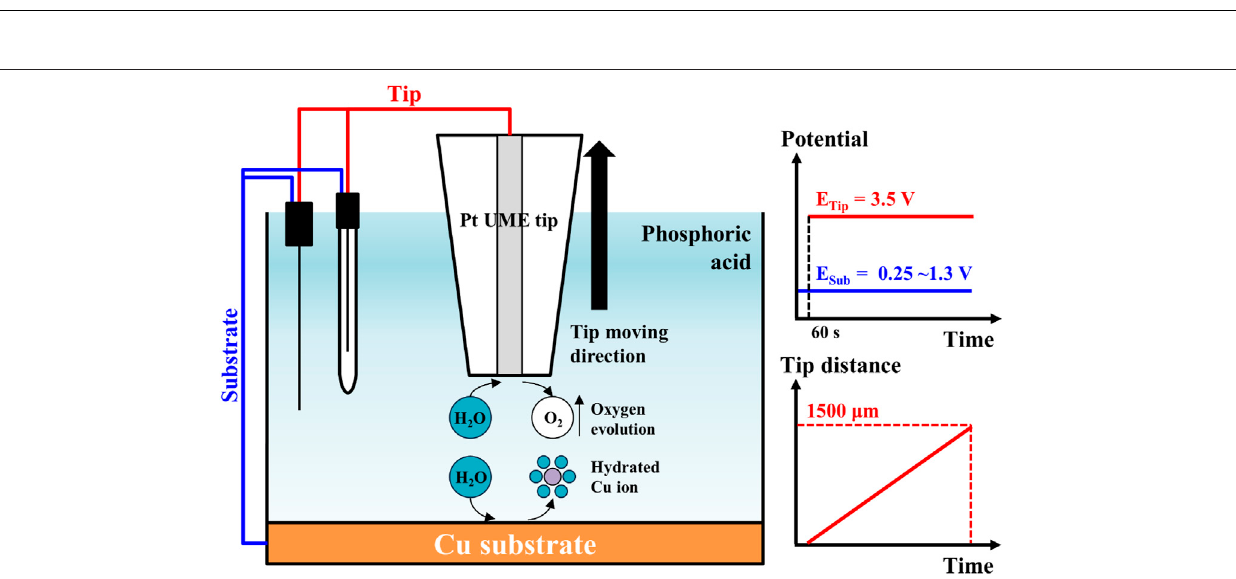
FIGURE 2 | Measurement scheme of electrode reactions for water electrolysis current measurement in SECM system. The Cu ions were dissolved from Cu substratebyapplied potentialfrom0.25to1.3 V.Thewatermoleculeshydrated thedissolvedCuions.OxygenevolutionoccursonPttipbyapplied potential 3.5 Vafter preconditioning for 60 s. A Pt tip moved with 5 μ m/s of scan